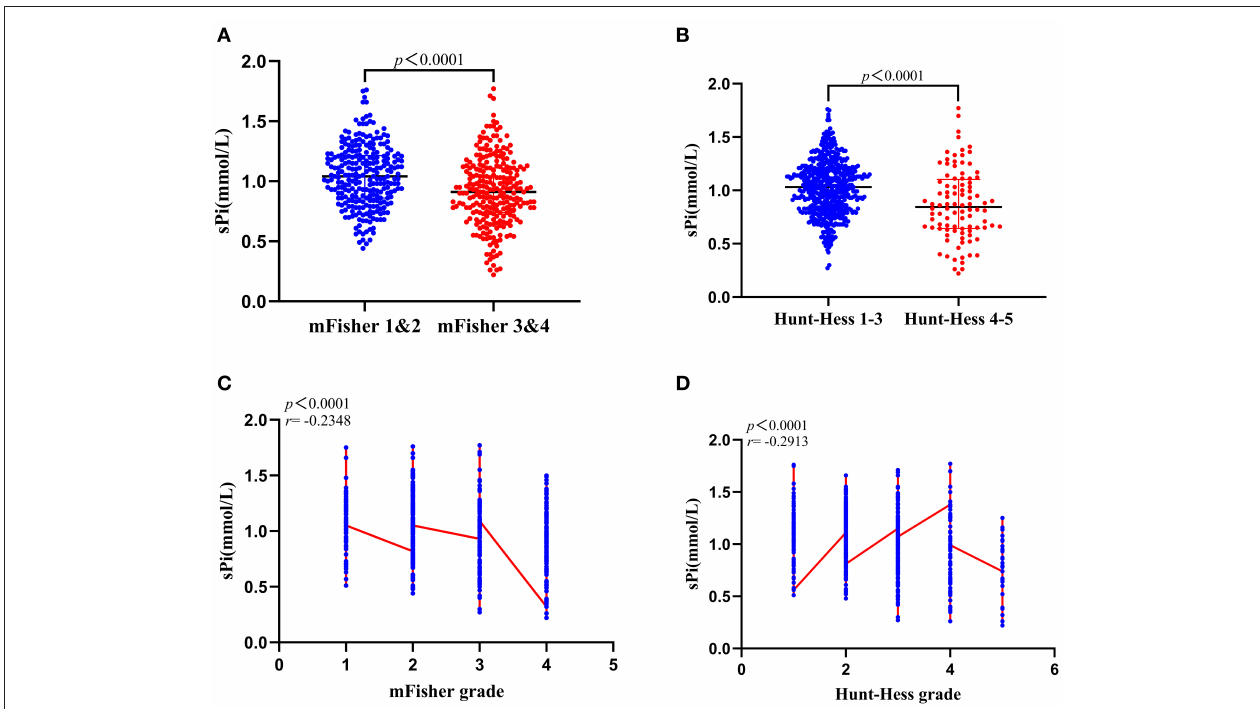
FIGURE 3 | Correlation between sPi level and initial clinical status at admission. (A) sPi levels in patients with mild (mFisher 1&2, n = 265) and severe (mFisher 1&2, n = 259) radiologic status. (B) sPi levels in patients with mild (Hunt-Hess grade 1–3, n = 539) and severe (Hunt-Hess grade 4–5, n = 96) clinical conditions. (C) The correlation of sPi levels with mFisher grade (mFisher 0 was not imputed). (D) The correlation of sPi levels with Hunt-Hess grade. Median with IQR was shown for all scatter plots in (A,B) . Mann-Whitney tests were performed to compare differences between groups. Correlations were determined using Spearman’s correlation analysis. aSAH: aneurysmal subarachnoid hemorrhage; IQR: interquartile range; sPi, serum phosphate ion; mFisher: modified